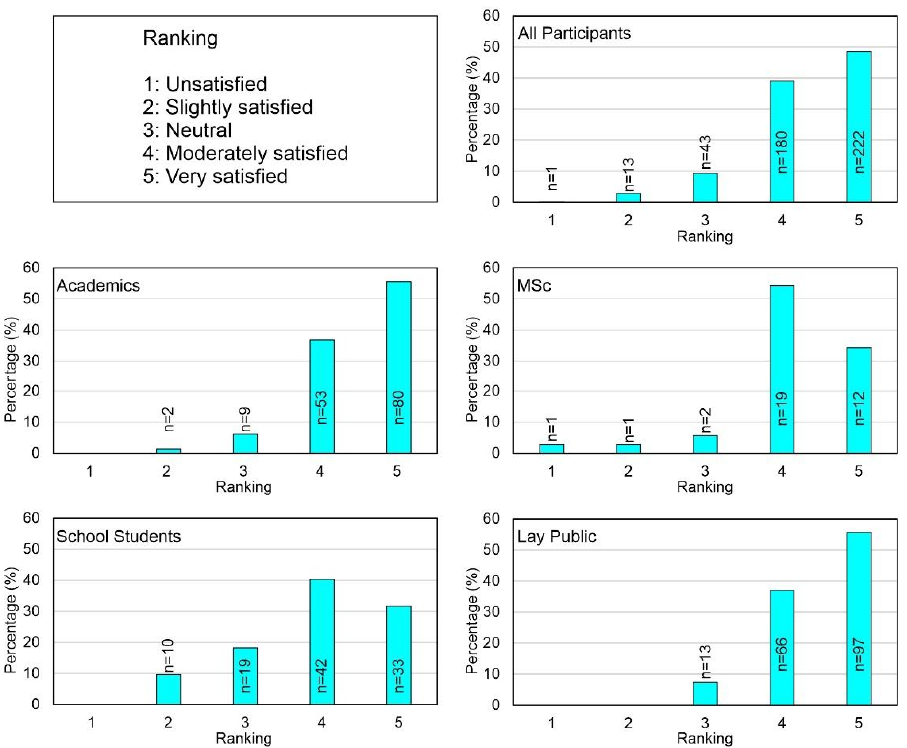
Figure 11. Bar charts showing the experience of the participants during their immersive virtual reality exploration. The results represent both the total number of participants and the background of each group respectively.